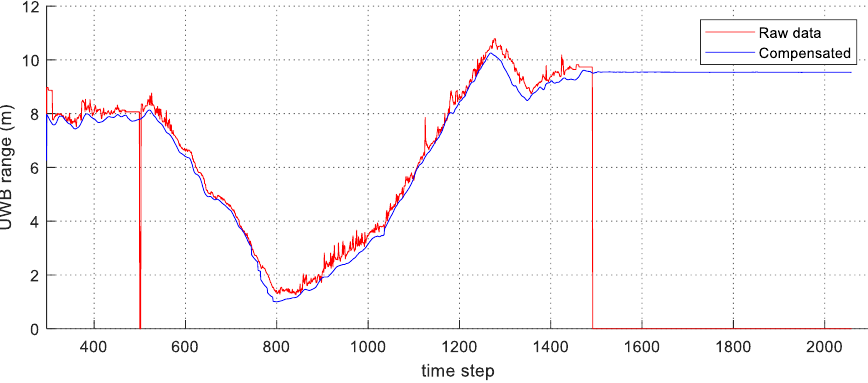
Figure 9. The result of the UWB range compensation with the estimated NLOS